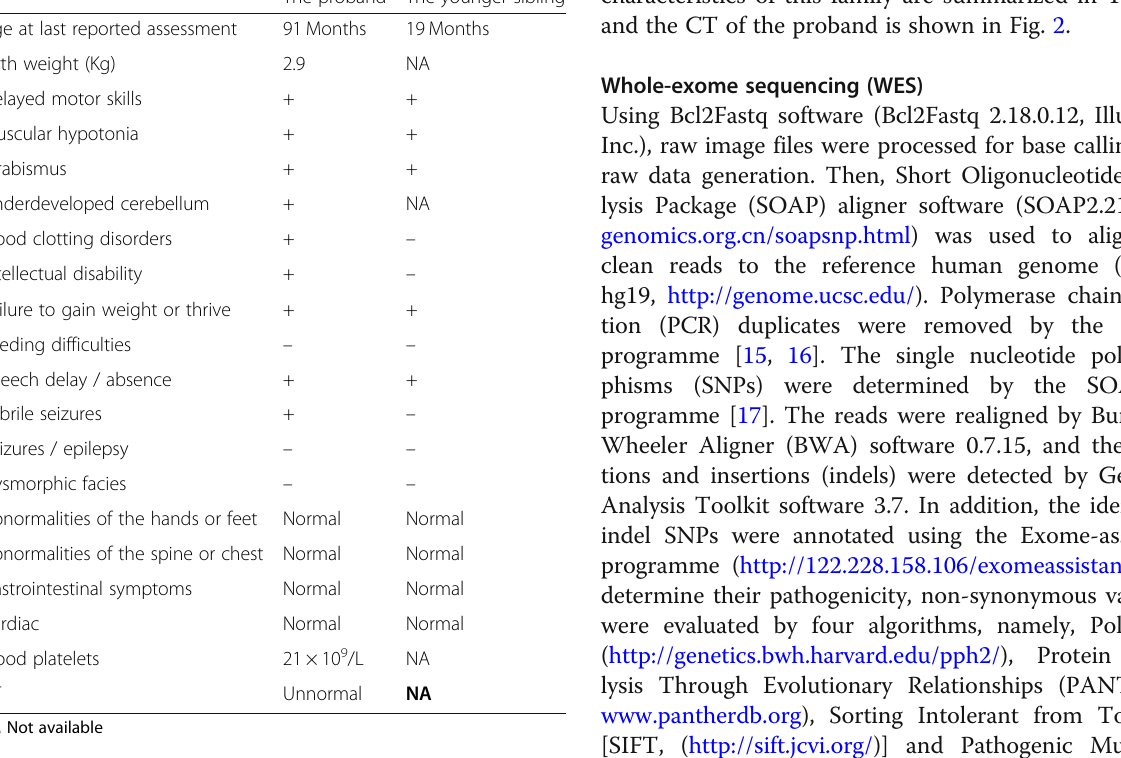
Table 1 Summary of the clinical presentation of patients with mutations The proband The younger sibling